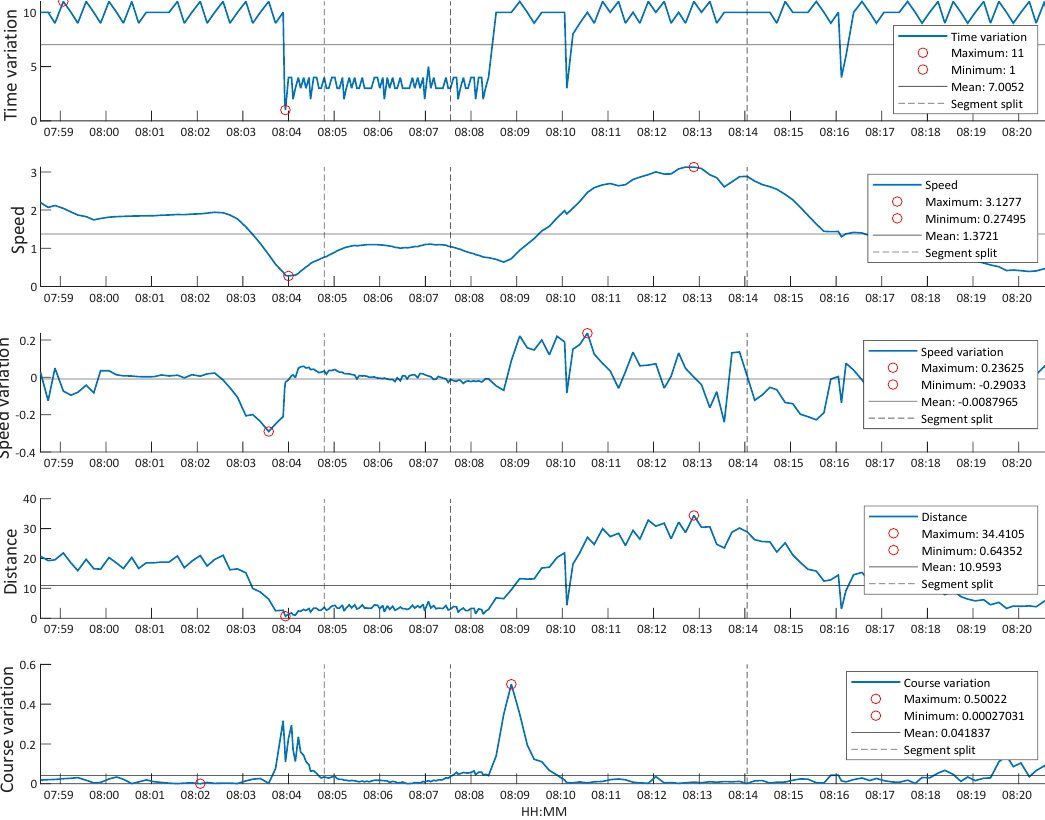
Figure 7. Extracted feature example.